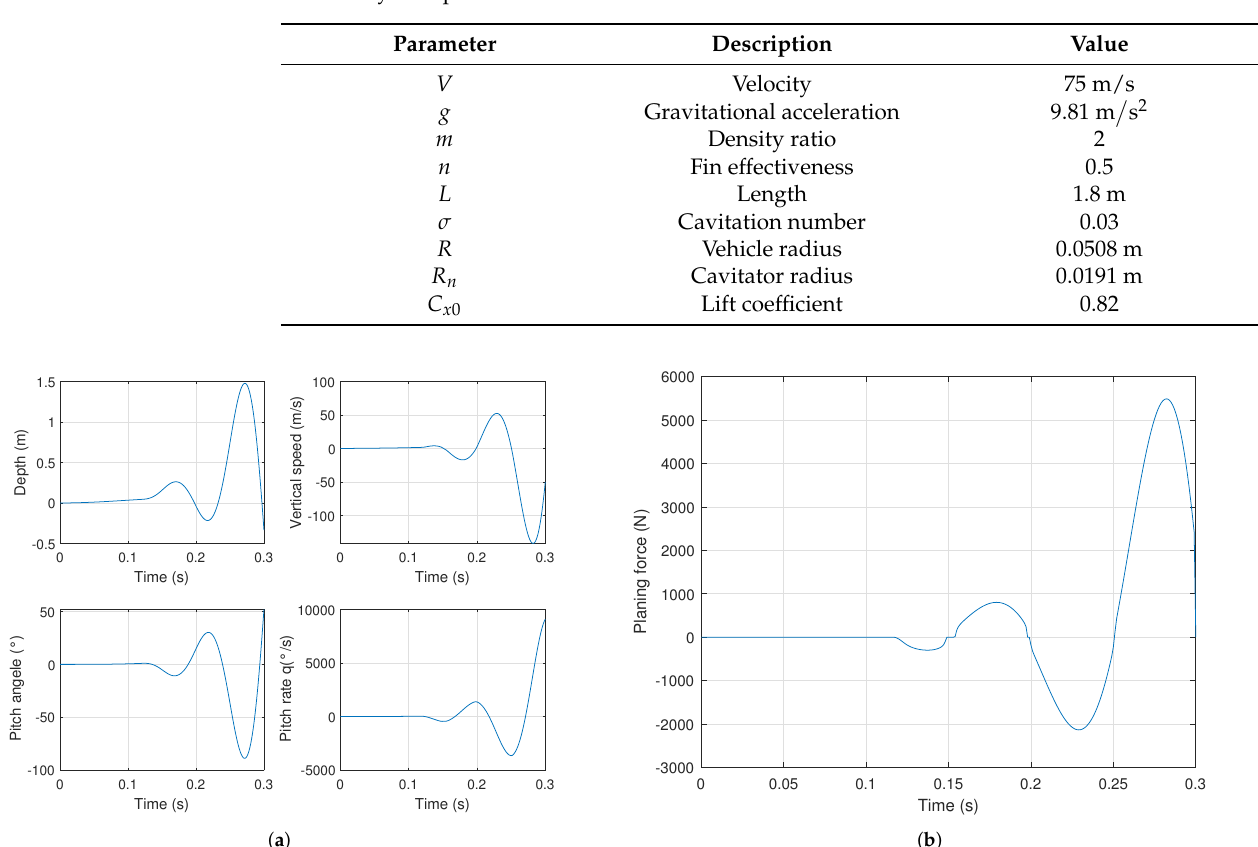
Table 1. System parameters for simulation model.